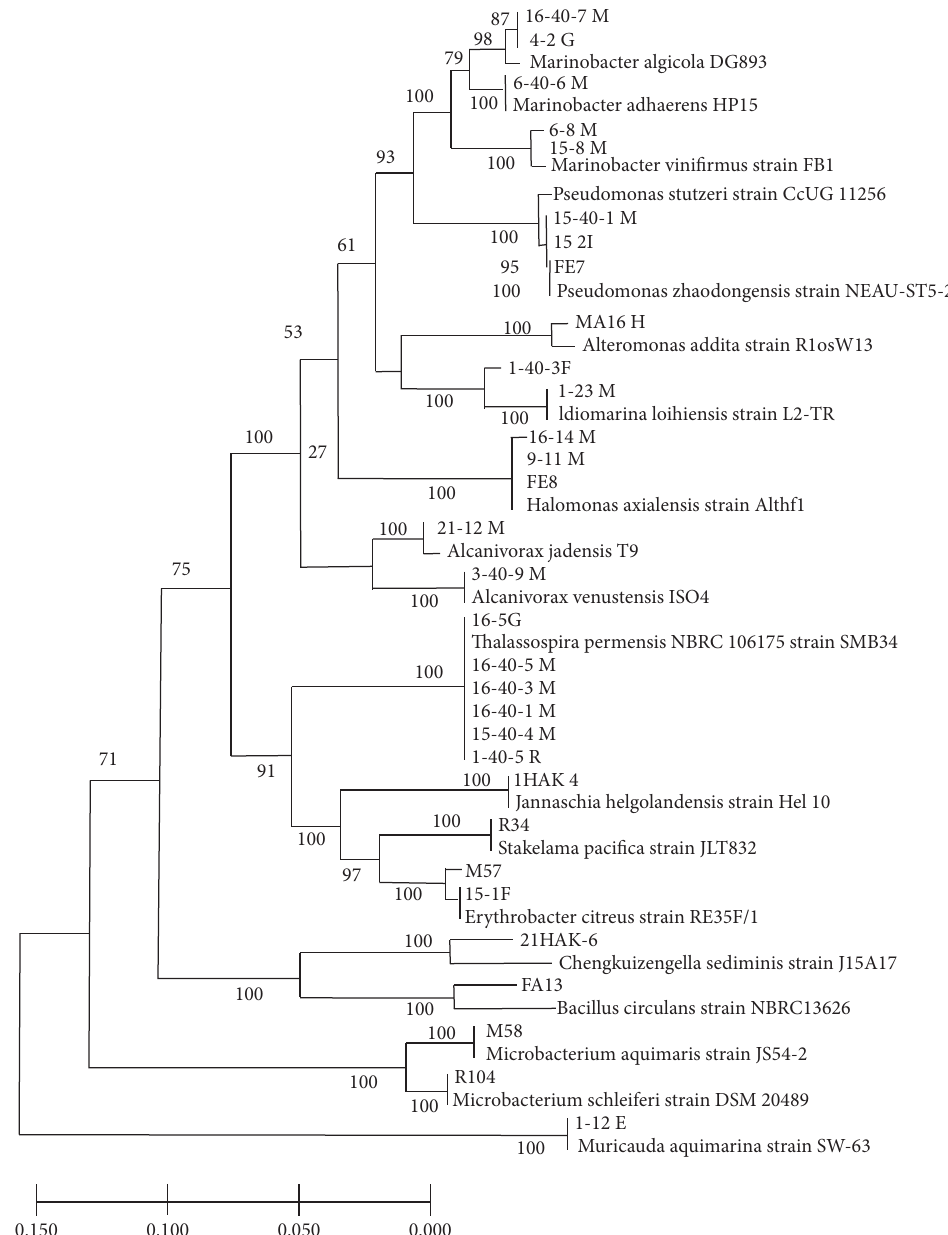
Figure 9: Neighbour-joining tree based on the 16S rRNA sequences of strains with high inhibition